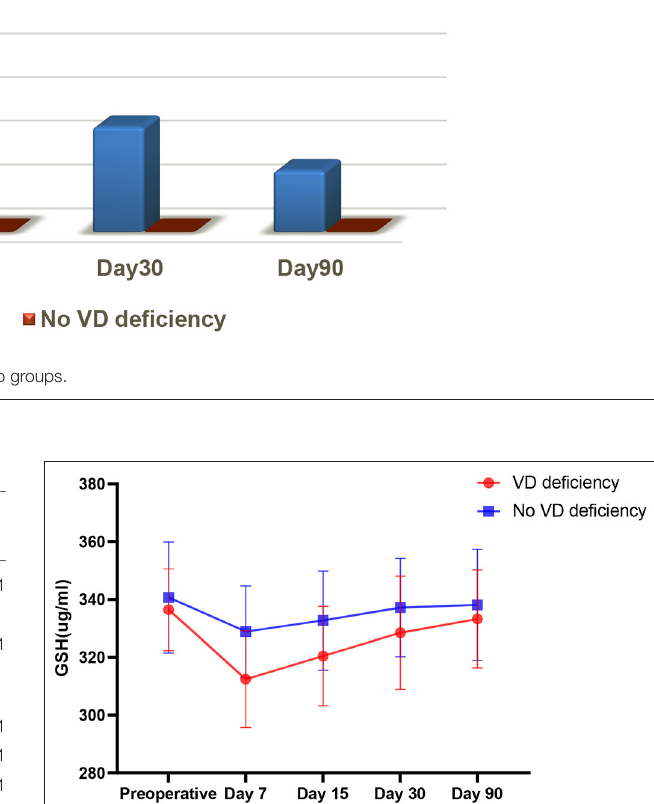
FIGURE 4 | Comparison of the change trend of serum GSH in patients with VD deficiency and non-VD deficiency before